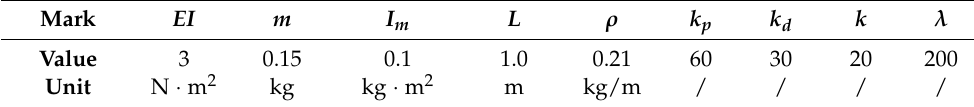
Table 1. Numerical simulation marks of micro-deformable manipulator system.